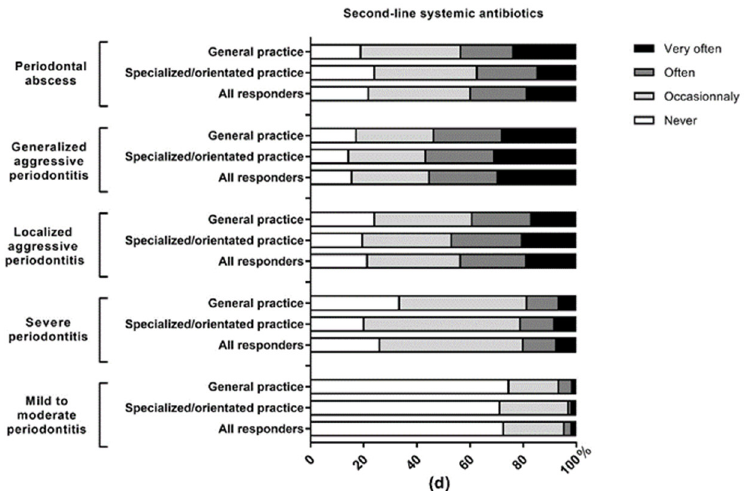
Figure 1. Use of systemic antibiotics in periodontal conditions by French dentists. ( a ) Knowledge of national guidelines about systemic antibiotics prescription; ( b ) exposure to training on systemic antimicrobial treatment in the previous 5 years; ( c ) use of antibiotics as a first-line periodontal therapy; ( d ) use of antibiotics as a second-line periodontal therapy. The data are presented as percentage and according to the affiliation of the practitioners. Specialized/orientated practice means that the dentist is affiliated to the SFPIO (French society of periodontology and oral implantology) and/or the CNEP (French college of University teachers in periodontology); general dental practice means that the practitioner did not declare membership in the SFPIO or CNEP. This include members of ReCOL (French general dental practice-based research network) and practitioners with no affiliation disclosed; * p < 0.05, ** p < 0.01, and *** p < 0.001.